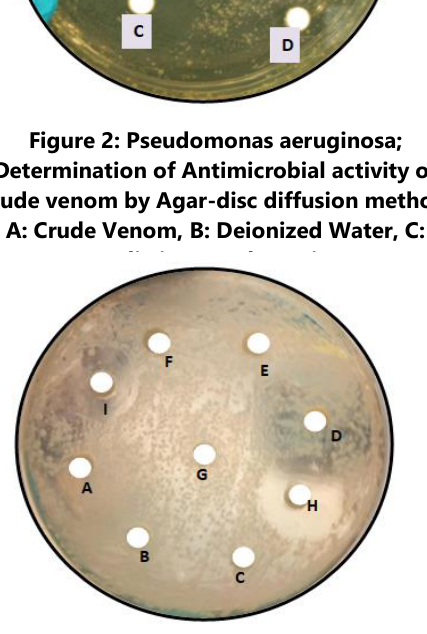
Figure 3: Pseudomonas aeruginosa; Antimicrobial activity of filtrate (<10KDa) and retentate